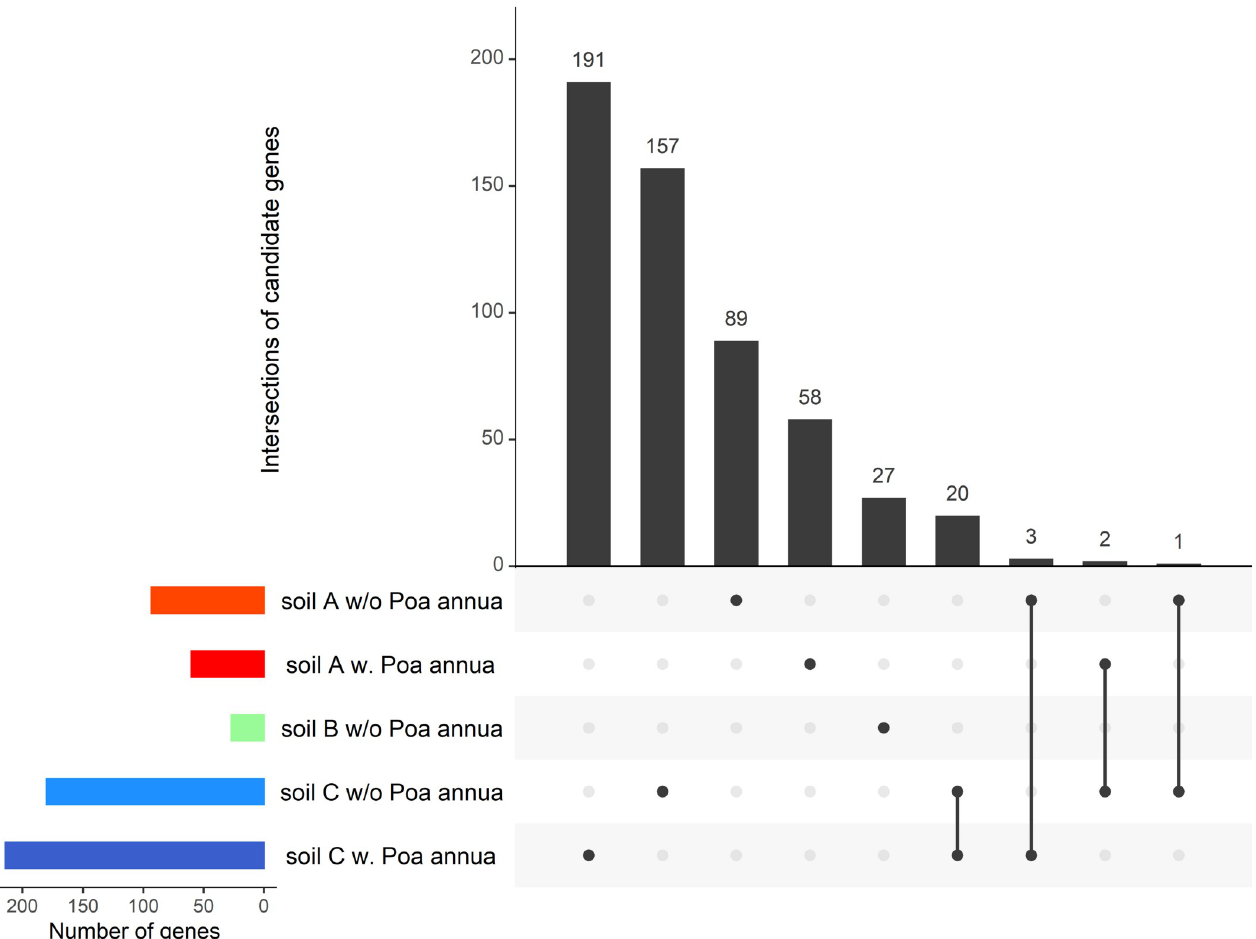
Fig 5. A variable architecture underlying natural genetic variation in disease index within each micro-habitat for which disease index was significantly heritable. UpSet plot illustrating the number of candidate genes that were either specific to a single micro-habitat (i.e. single black dots) or common between two micro-habitats (i.e. black dots connected by a solid line). ‘w/o’: absence of P . annua , ‘w.’: presence of P . annua . For each micro-habitat, the number of candidate genes identified by GWA mapping (colored bars) corresponds to the sum of the numbers of candidate genes above the grey bars for which dots are present. For instance, the total number of candidate genes identified by GWA mapping for the micro-habitat ‘soil C w. Poa annua ’ is 214, which corresponds to the sum of the values 191, 20 and 3.